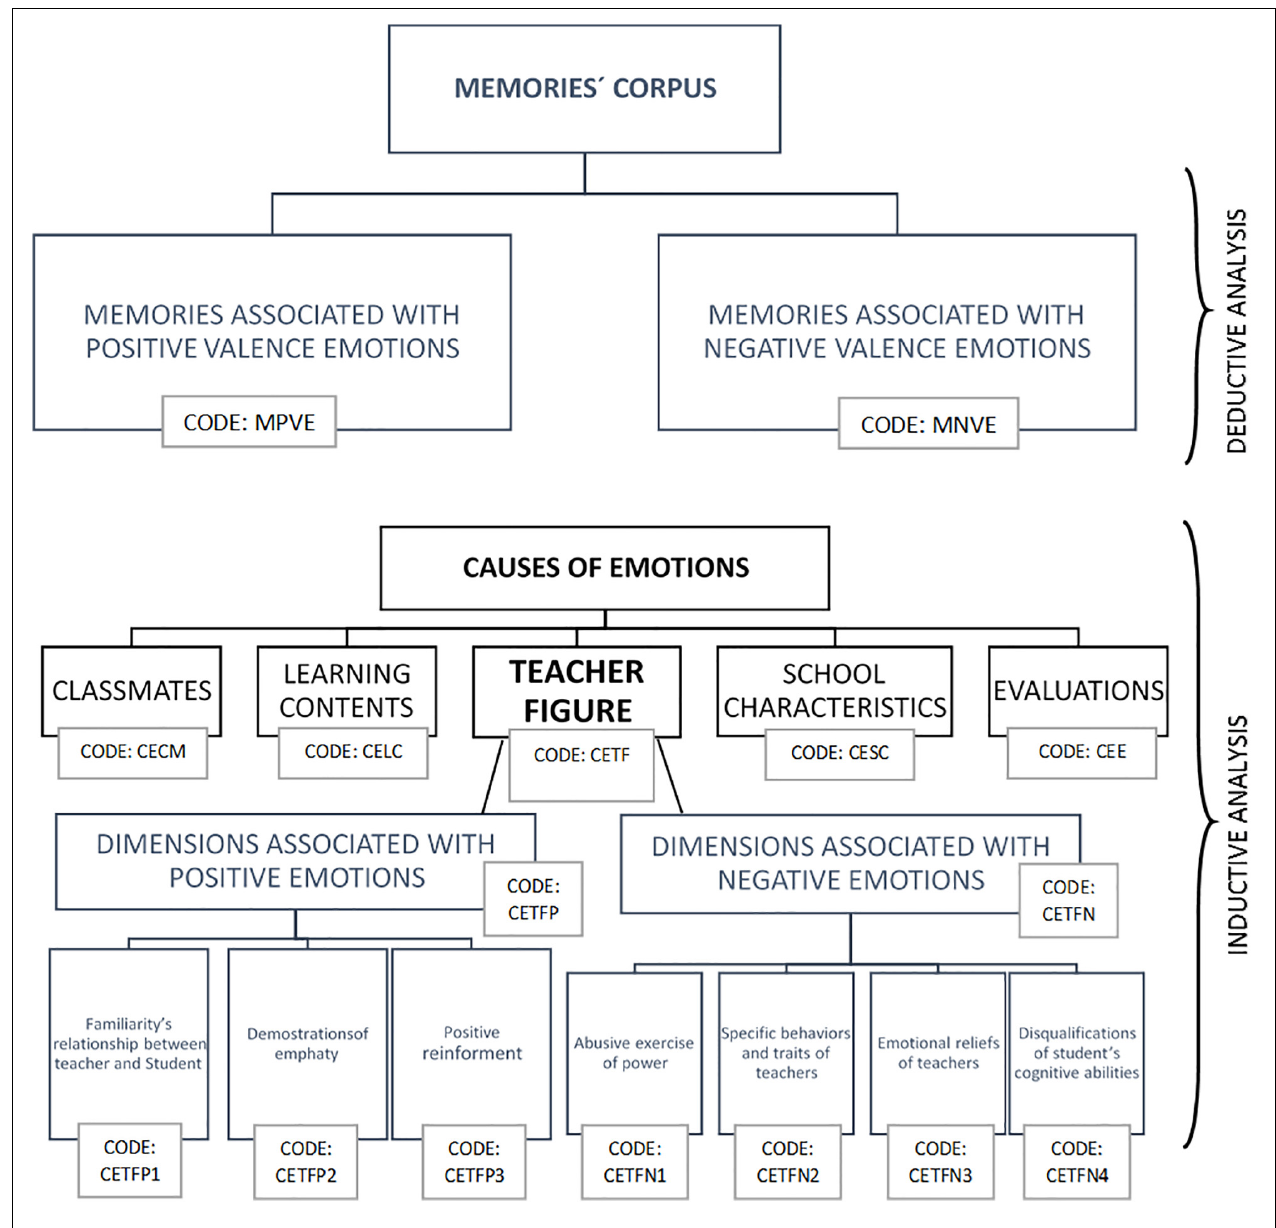
FIGURE 2 | Coding and categorization